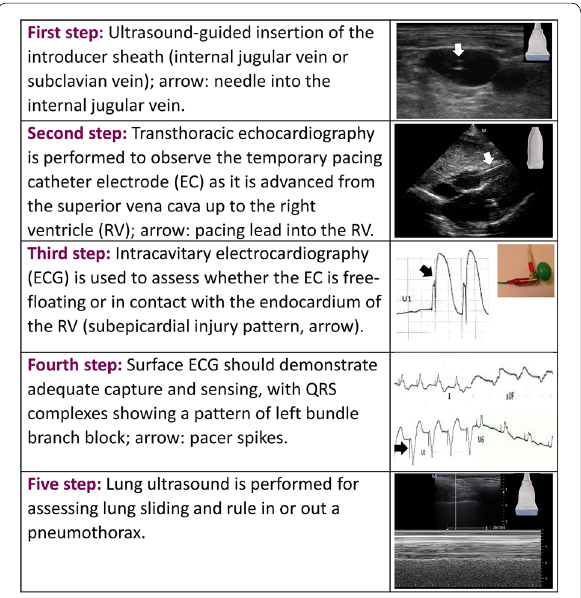
Fig. 6 Summary of the combined technique: ultrasound and intracavitary ECG technique for temporary transvenous